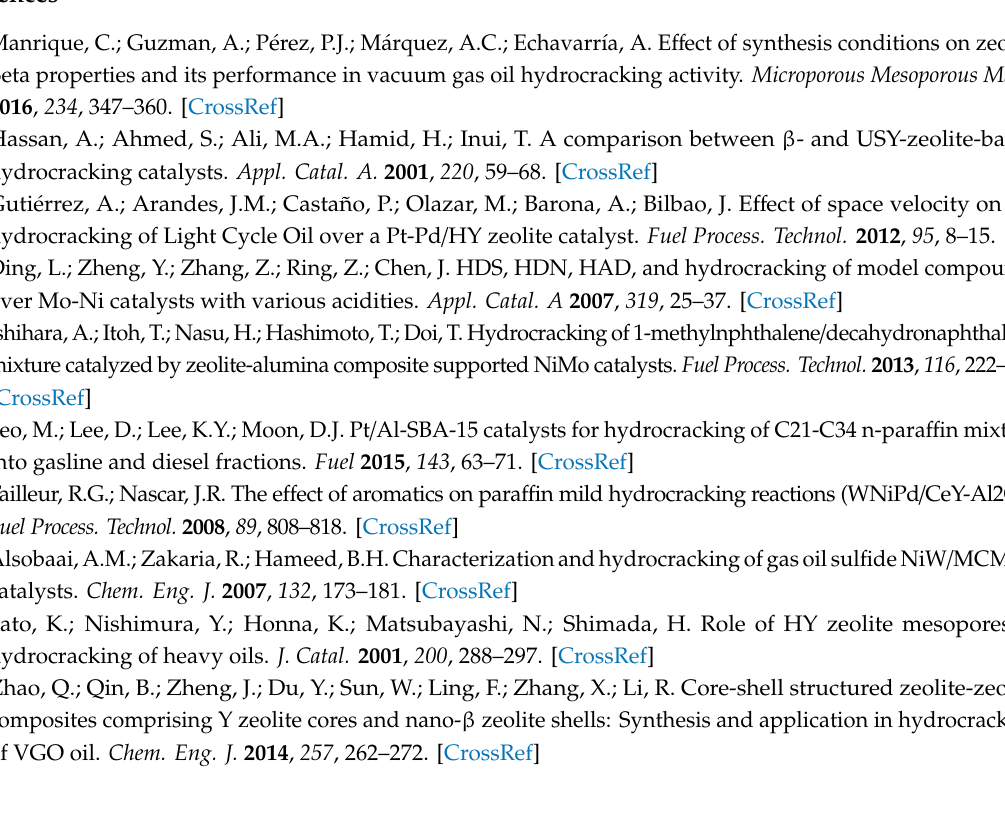
Figure S1: XRD patterns of the zeolite samples, Figure S2: BJH pore size distribution of the adsorption branch of zeolites, Figure S3: TEM images of the zeolites. MUSY-B and MUSY-C (Right), Figure S4: 27 Al MAS NMR Spectra of the samples, Figure S5: NH 3 -TPD properties of the zeolite samples, Figure S6: Hydrocracking products distributions over the catalysts containing MUSY-A, MUSY-B and